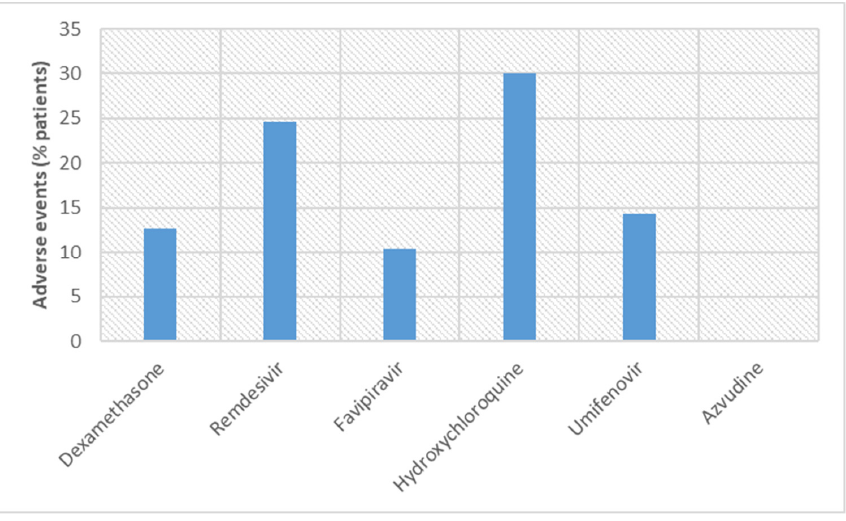
Figure 5. Comparison of adverse events observed in COVID ‐ 19 patients in clinical trials conducted with repurposed drugs.